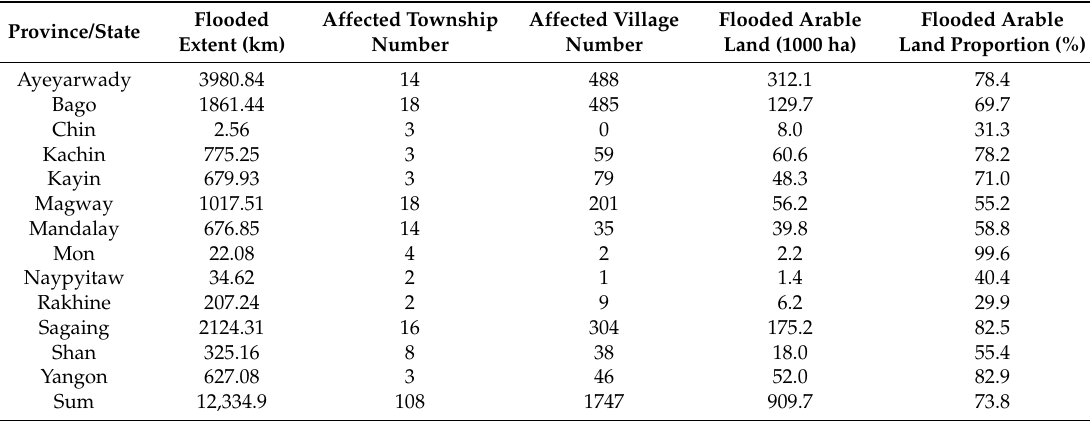
Figure 8. Flooded Residential Area Mapping Product. Table 2. Flood Impacted Townships, Villages, and Arable Land.